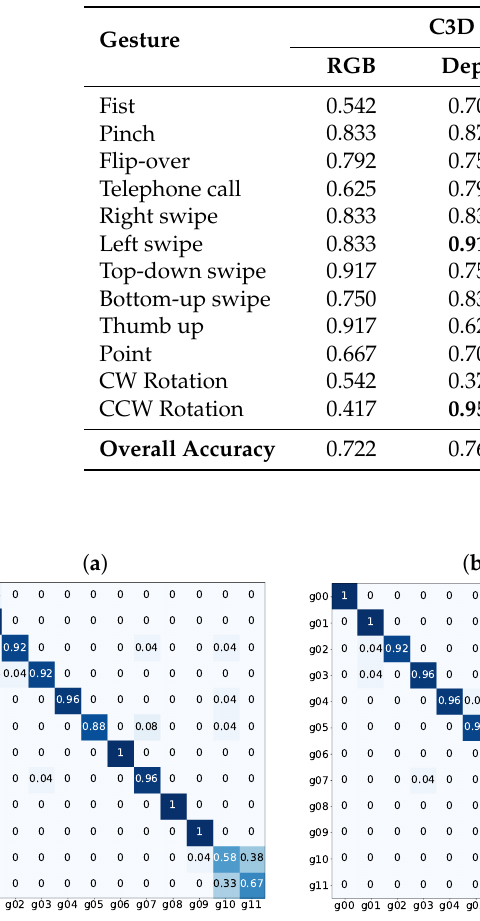
Table 4. Comparison with competitors on the Briareo dataset [20]. Both overall accuracy and accuracy per gesture are reported.